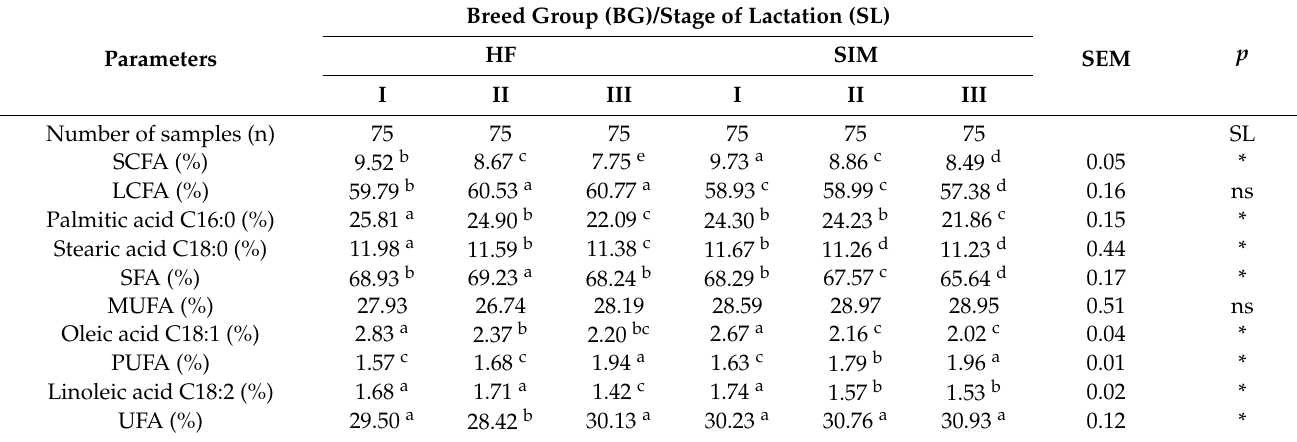
Table 5. Contents of the main fatty acid fractions in milk depending on the breed group and stage of lactation.